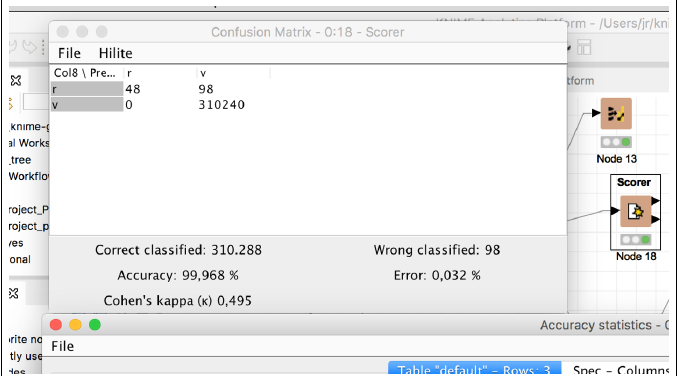
Fig. 10. Confusion matrix using S5 model and the decision tree over a dataset that contains APT